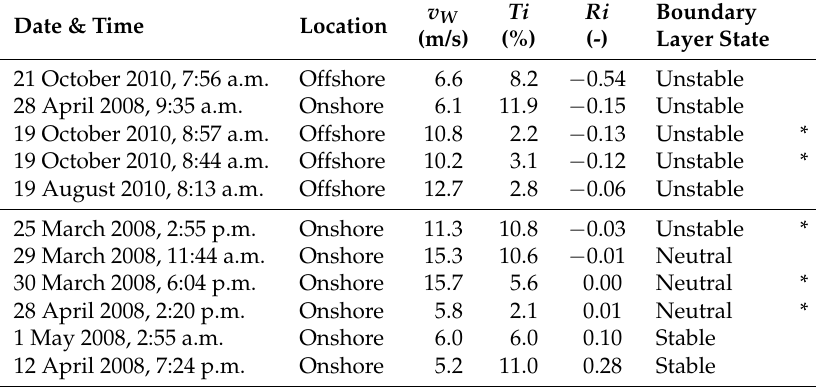
Table 1. Summary of selected Atmospheric Boundary Layer (ABL) stability cases: wind speeds ( v W ) and turbulence intensities ( Ti ) from cup anemometers, Ri numbers and estimated ABL states. Date & Time